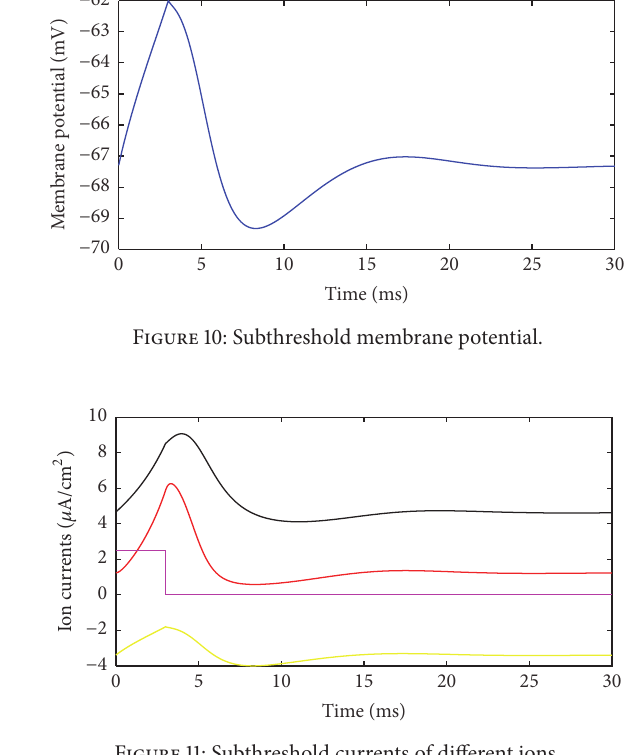
Figure 11: Subthreshold currents of different